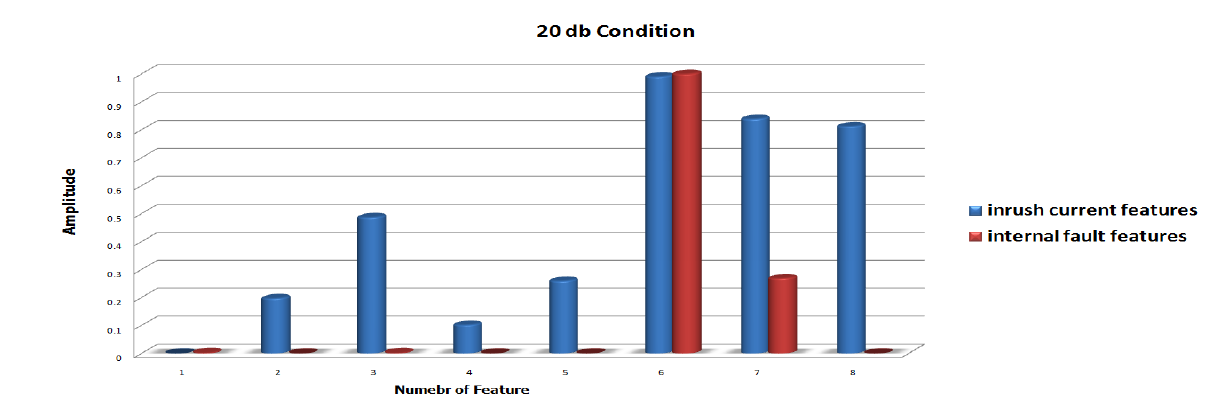
Figure 3. The values of the features of inrush current and internal fault in 20 dB noise